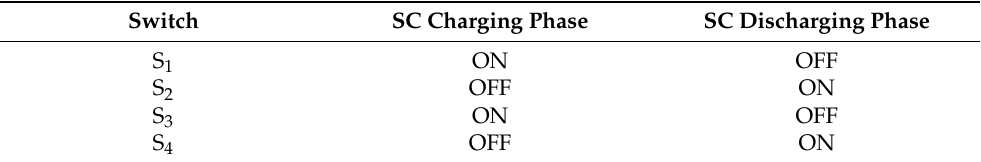
Table 2. Switching sequence of the SCAWI-PV